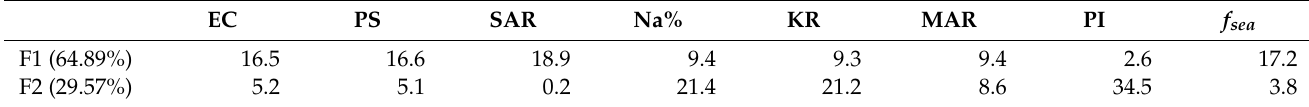
Table 3. Percentage of indices contribution factor